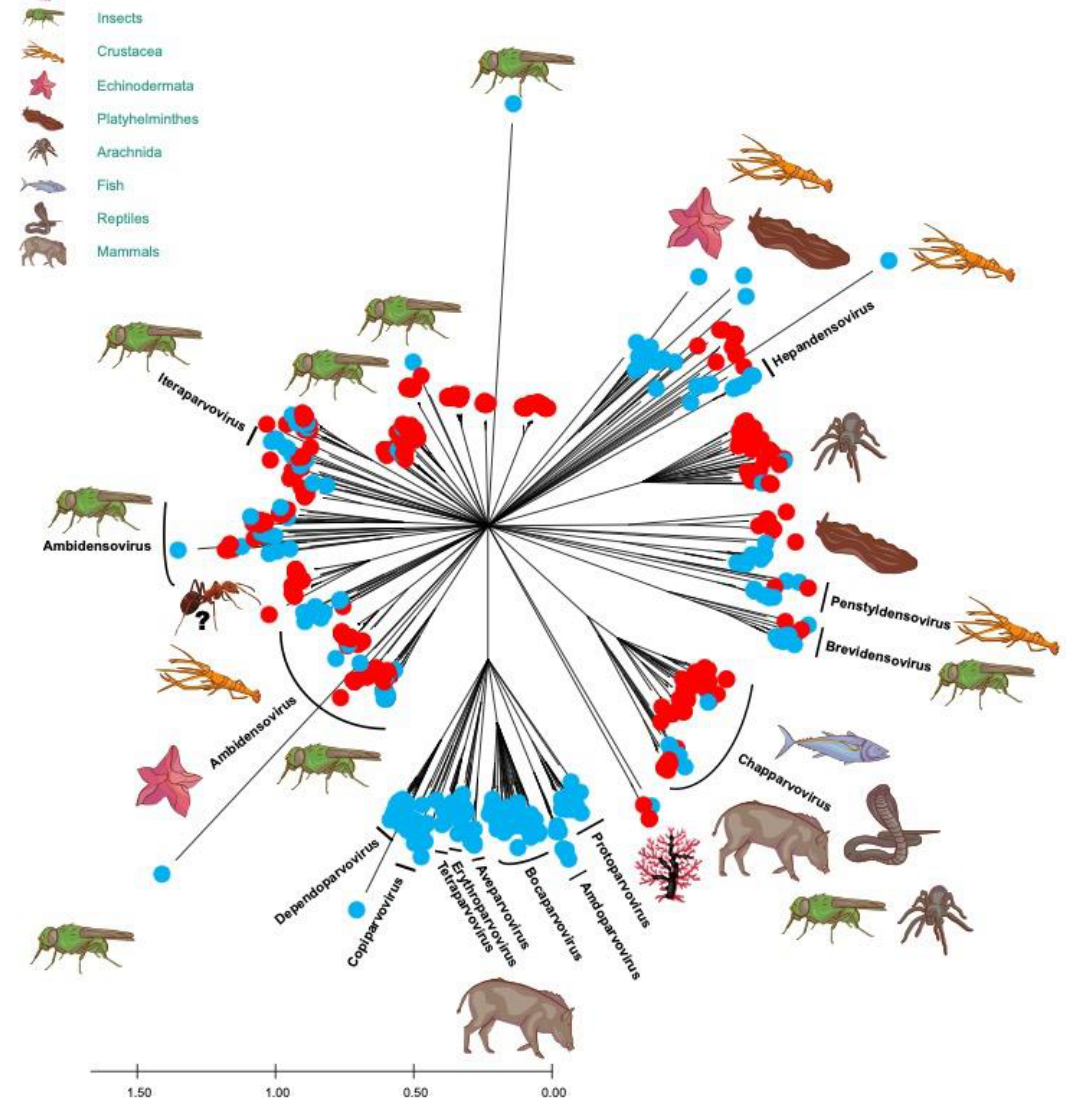
Figure 4 – Phylogeny of the sequences of the viruses in the family Parvoviridae . The Neighbor joining phylogenetic tree was generated using alignments of SF3 protein sequences with 500 bootstrap replicates to quantify branch support. Sequences in red refer to army ant-associated contigs. Putative hosts of several parvoviruses are depicted at the extremity of the branches. Specifically, an ant and a question mark are depicted nearby the clade located between both ambidensovirus groups, because it is plausible that the parvoviruses from which these sequences were derived may have been directly infecting the army ants. Genera of the Parvoviridae family are also indicated. The scale bar depicts the number of amino acid substitutions per